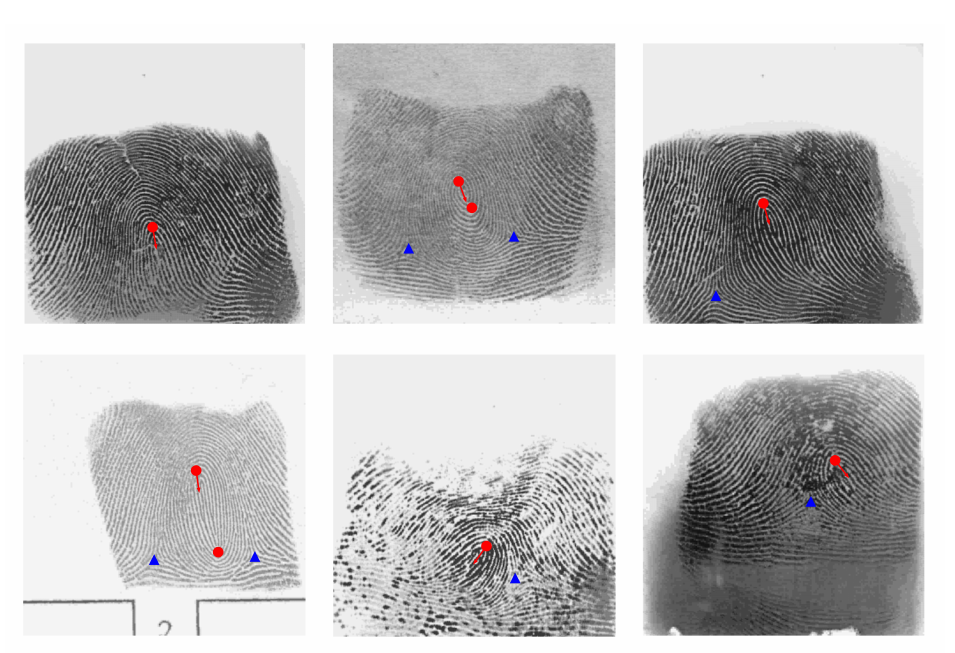
Figure 4. Illustrations of of the performance of our method over the Ten-Finger Card fingerprint dataset. Red dots and blue triangles denote the core points and delta points respectively, while the red arrows represent the orientations of up-core